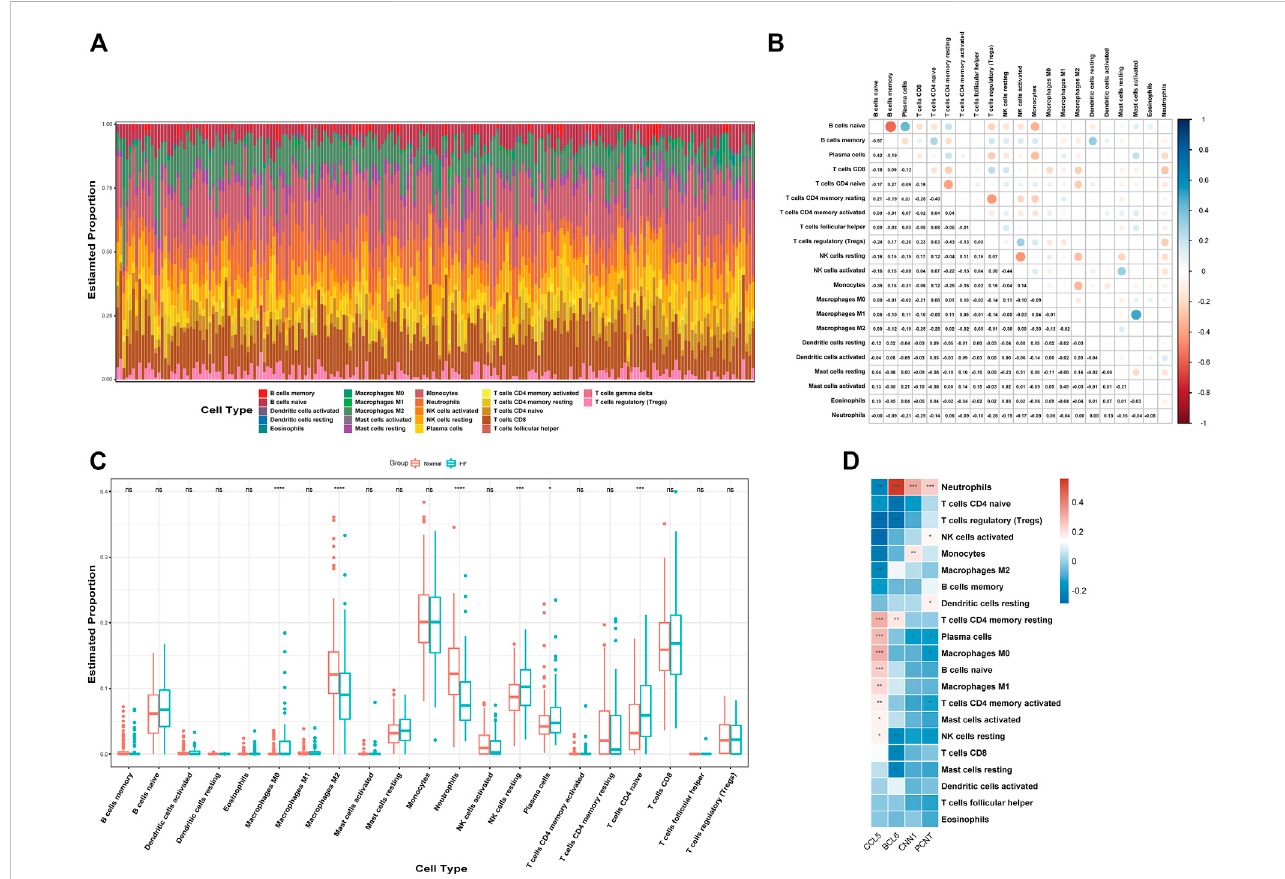
FIGURE 8 Analysis of immunecell in fi ltration. (A) Relative percentage of 22 immune cell subtypes. (B) Correlation heatmap of 21 immune cells. (C) Immunecells in HF and normal samples. (D) Relationship between hub genes and immune cells related to HF. HF, heart failure; p -values are shown as *, p < 0.05; **, p < 0.01; ***, p < 0.001; ns, not signi fi